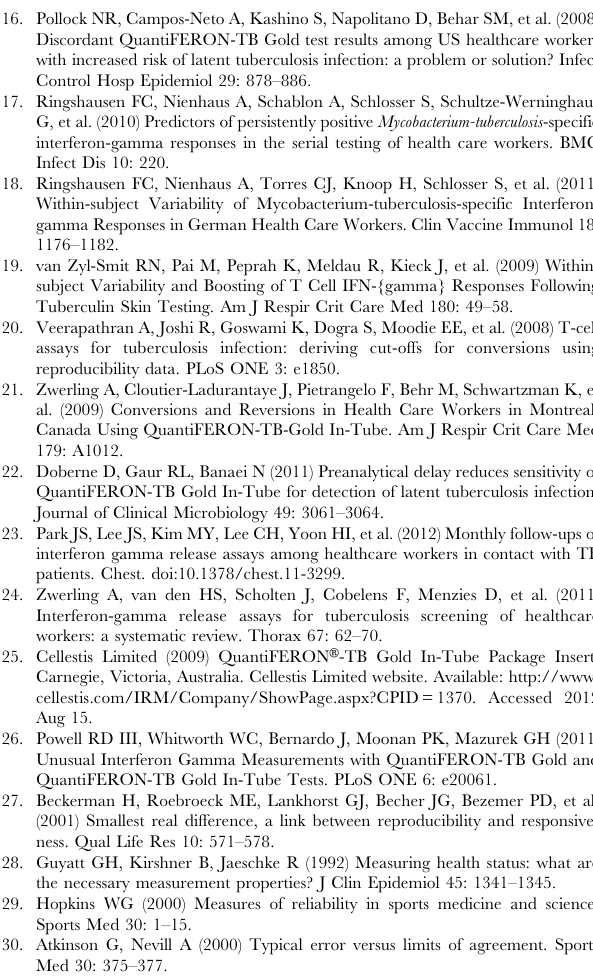
Table S1 QuantiFERON-TB Gold In-Tube test results for subjects with discordant interpretations.